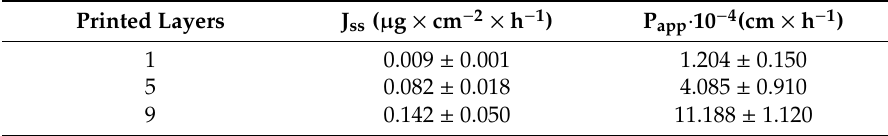
Table 5. Permeation parameters for NA.